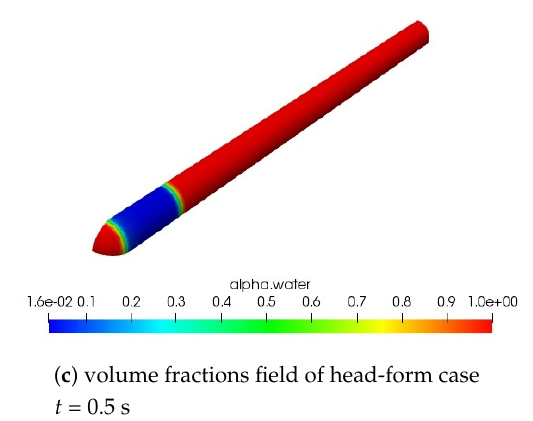
Figure 9. Visualization result of different cases.